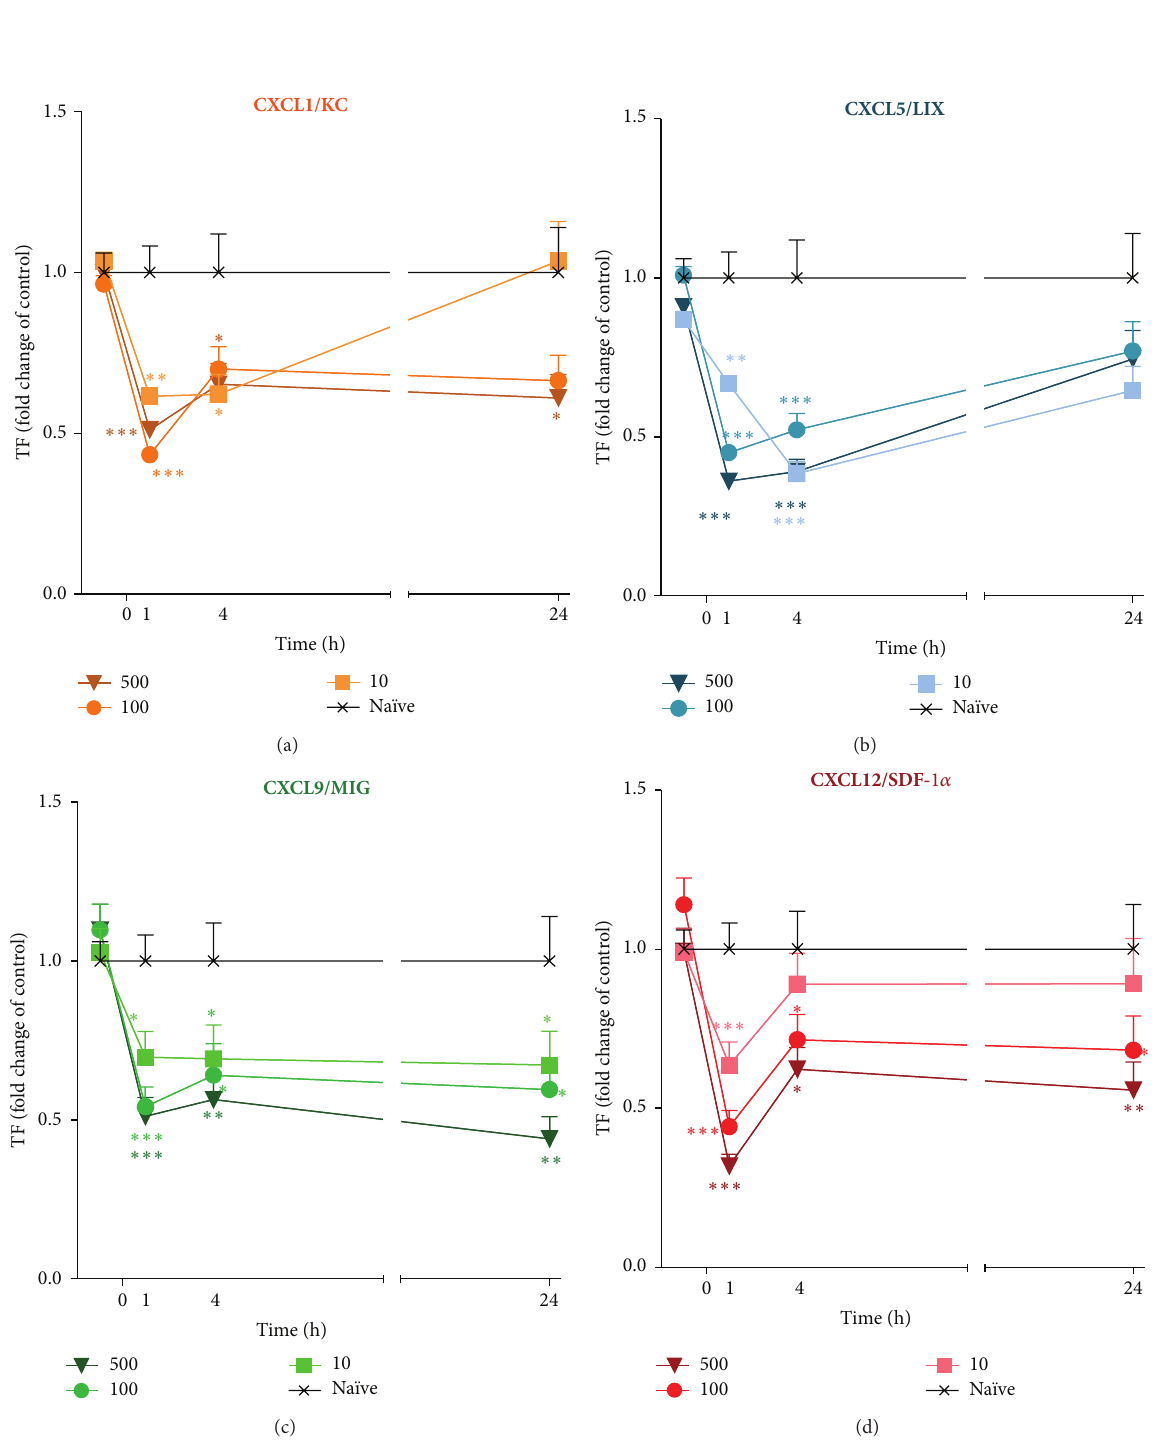
Figure 4: Effects of CXCL1, CXCL5, CXCL9, or CXCL12 administration on the nociceptive threshold. The influence of a single intrathecal administration of 10ng, 100 ng, or 500 ng/5 𝜇 L of CXCL1 (a), CXCL5 (b), CXCL9 (c), or CXCL12 (d) on the nociceptive threshold was evaluated using a tail-flick test. The measurements were taken 1, 4, and 24 hours after chemokine administration. The data are presented as fold change in the control (na¨ıve) ± S.E.M. (6–16 mice per group). Intergroup differences were analyzed by an ANOVA and Bonferroni’s Multiple Comparison Test. ∗ 𝑃 < 0.05 , ∗∗ 𝑃 < 0.01 , and ∗∗∗ 𝑃 < 0.001 indicate a significant difference; the statistical analysis was performed versus control (na¨ıve)